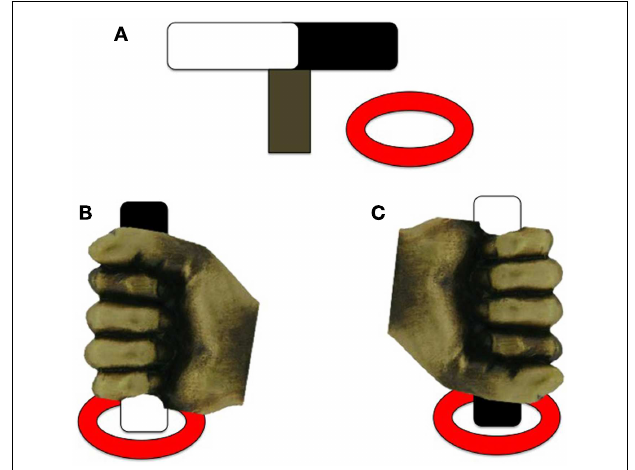
FIGURE 2 | Experimental design of the underhand grasps used in Hughes ( 17). (A) The rod and ring set-up; (B) example of a comfortable end-state underhand grasp; (C ) example of an uncomfortable end-state underhand grasp. Note that the rod is positioned the same for each trial, only the color of the end of the rod to be placed in the ring differs between trials [adapted from Ref.